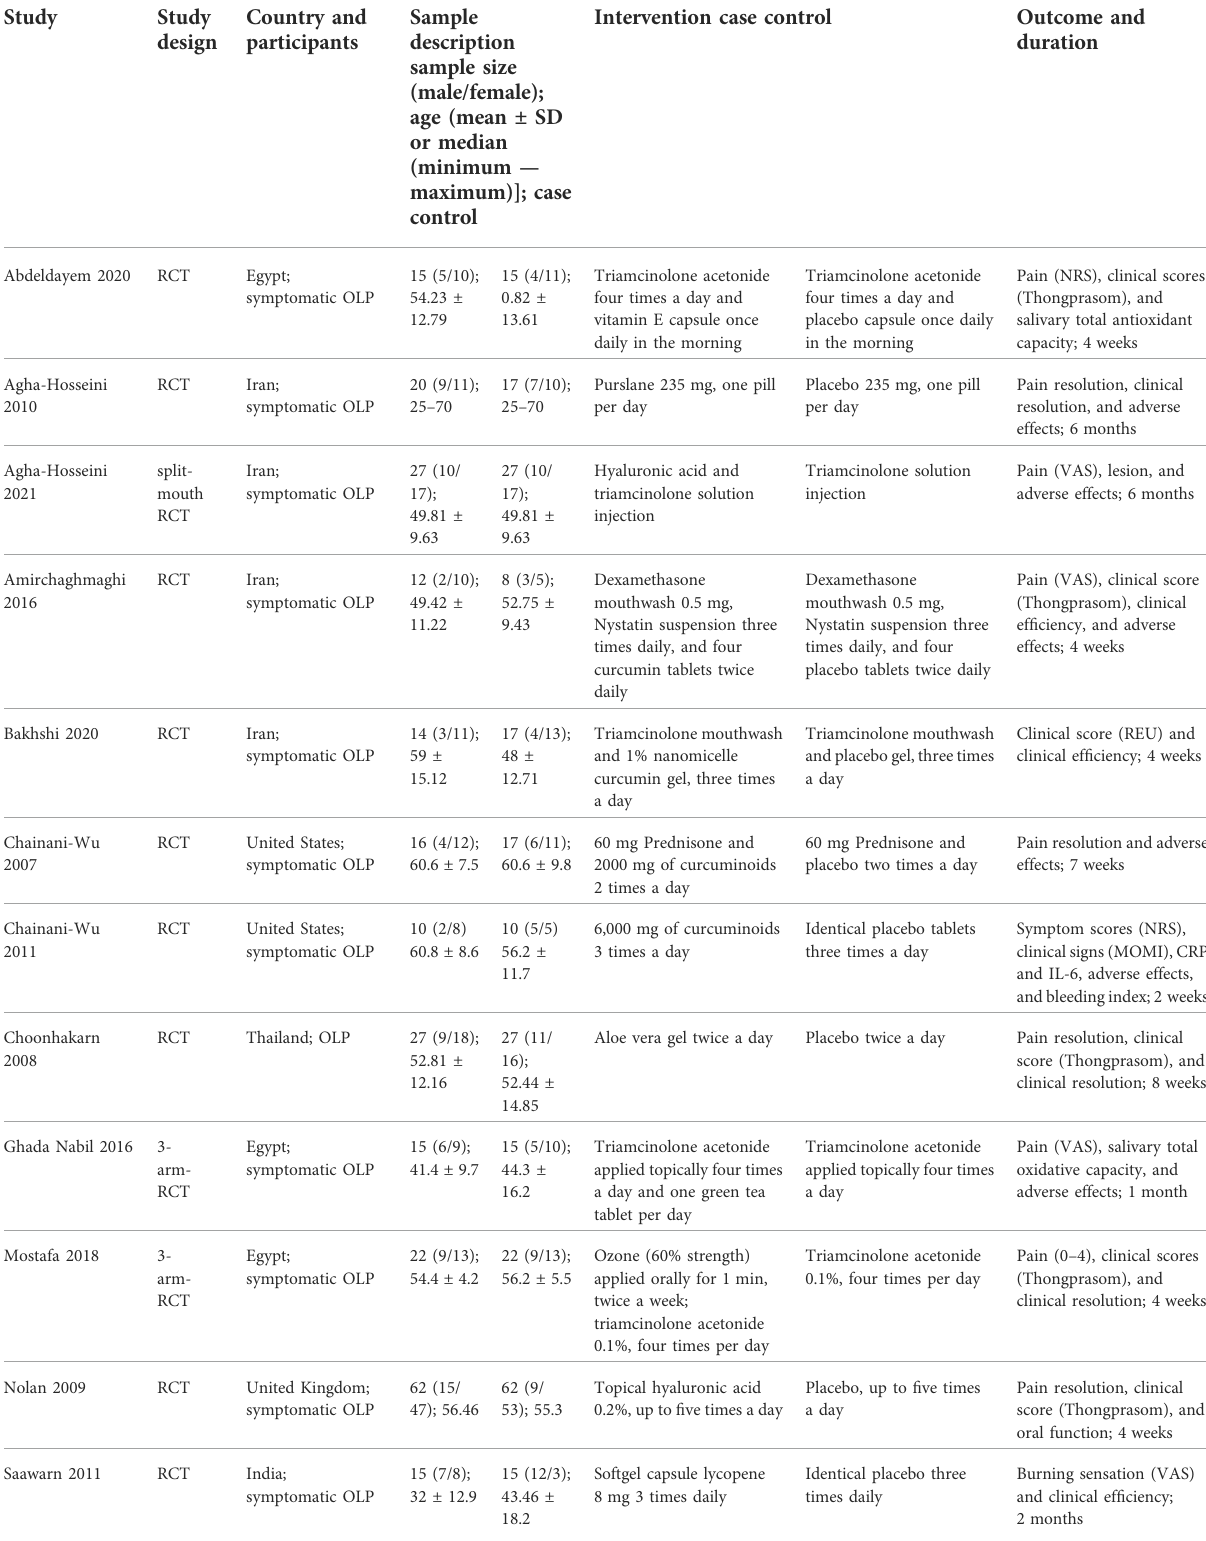
TABLE 1 Summary of the included